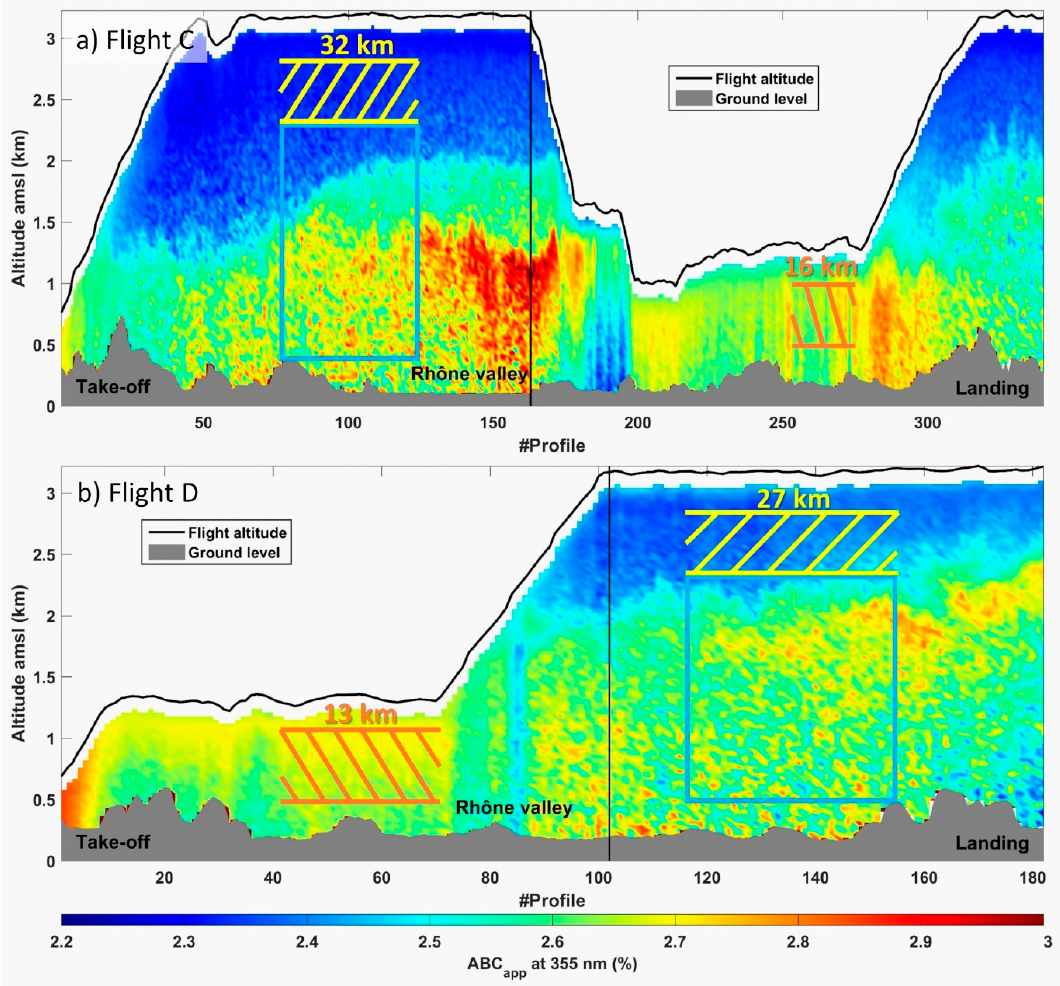
Figure 8. Vertical profiles of the normalized apparent backscatter coefficient (ABCapp) corrected for the molecular transmission for: ( a ) flight C and ( b ) flight D on 24 June 2015. Profile number (i.e., time) is indicated in abscise. The profiles used for the study are hatched in orange for the constraint zone between 0.5 and 1 km amsl and yellow for the reference zone between 2.35 and 2.85 km amsl. The inverted profiles are framed in blue. The horizontal distances over which these signals are averaged are indicated.